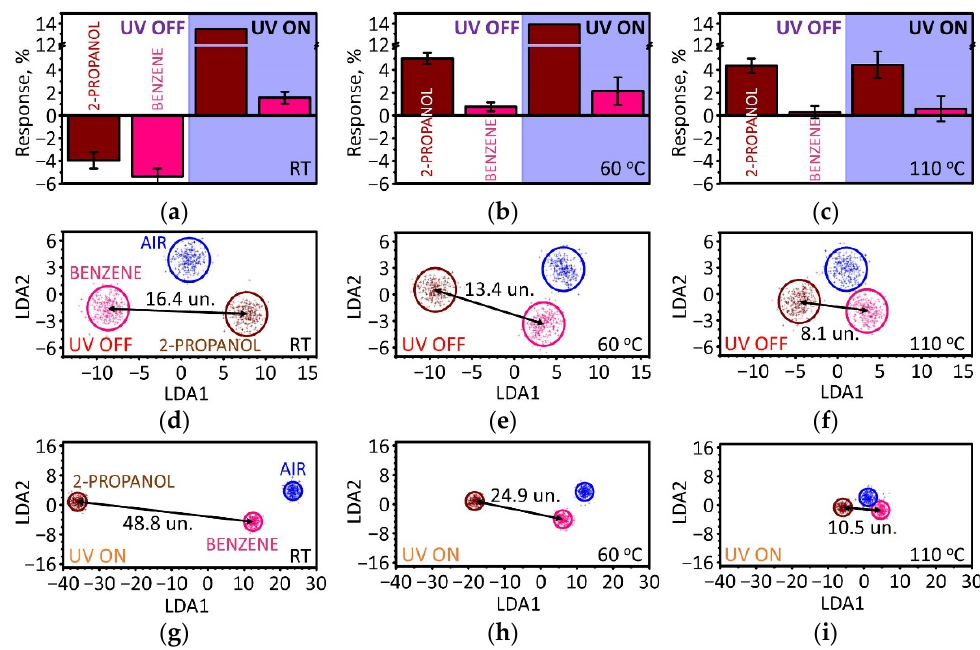
Figure 8. Comparison of chemiresistive responses of TiS 3 NW mat-based sensor elements to isopropanol and benzene vapors, both at 100 ppm concentration. ( a – c ) Magnitudes of the chemiresistive responses at RT ( a ), 60 °C ( b ), and 110 °C ( c ) with and without UV assistance. ( d – i ) LDA diagrams of the vector signals from the on-chip sensor array under various operation regimes: RT ( d ), 60 °C ( e ), 110 °C ( f ), RT/UV ( g ), 60 °C/UV ( h ), and 110 °C/UV ( i ). The points are vector signals, ellipses are built according to a suggestion of normal distribution of data within each class around the gravity centers with 0.95 confidence level.